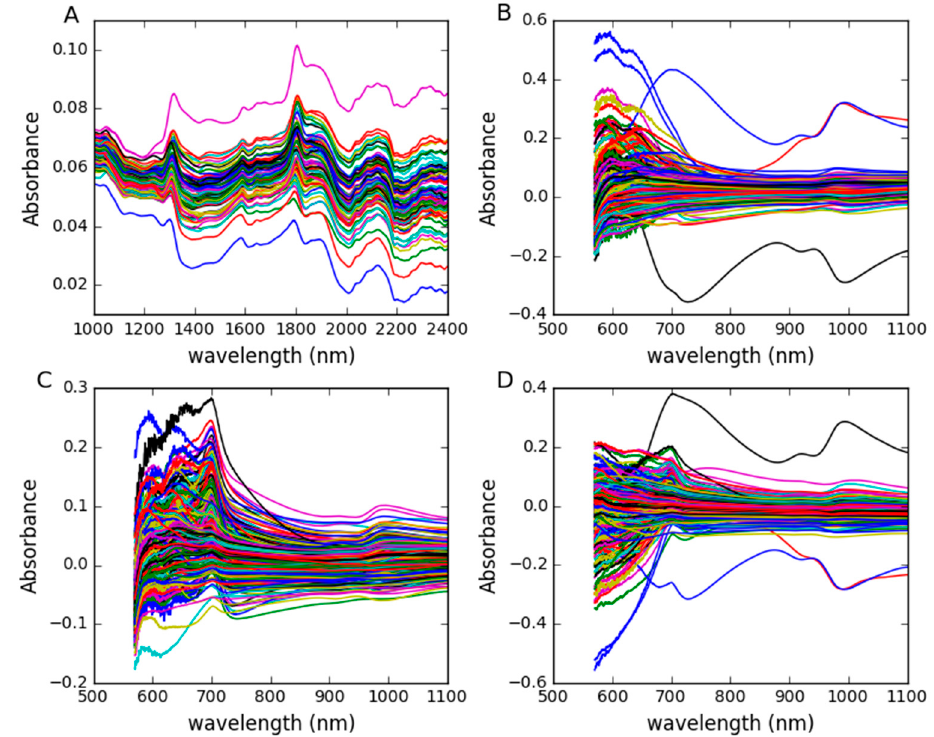
Figure 11. ( A ) Spectral differences between m5 and mp6 of corn samples; ( B ) spectral differences between B1 and B2 of wheat samples; ( C ) spectral differences between B1 and B3 of wheat samples; ( D ) spectral differences between B2 and B3 of wheat samples.